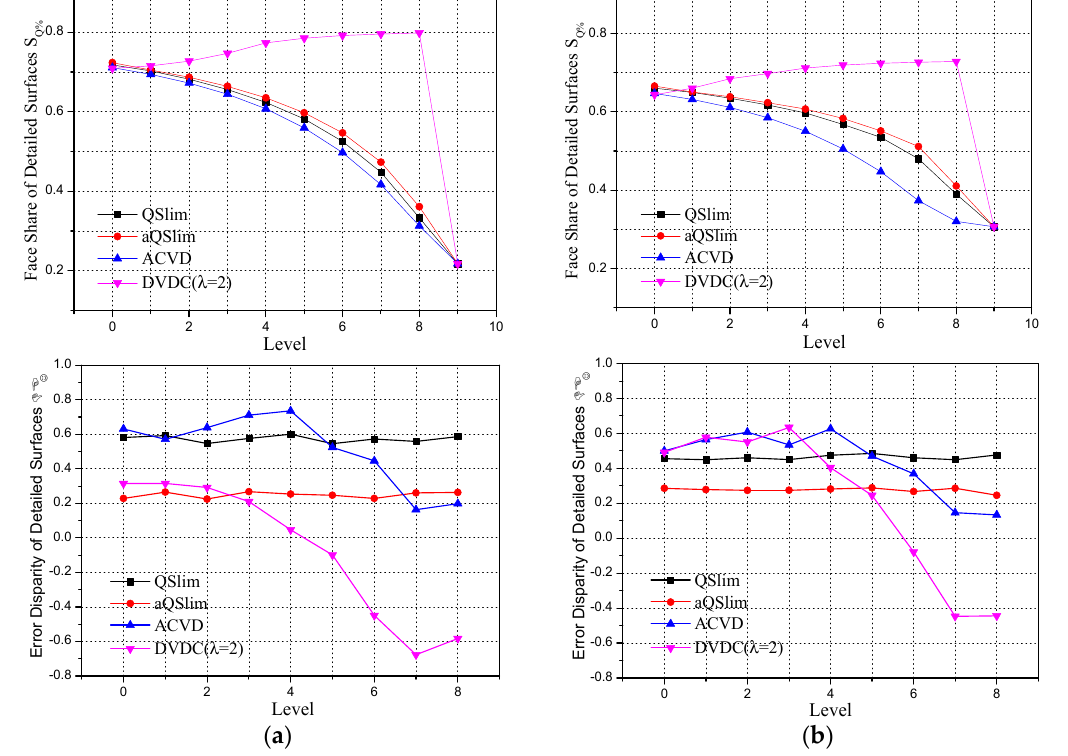
S and the error disparity Q% λ= S and E ϑ ς . It ) performs well in terms of Q%